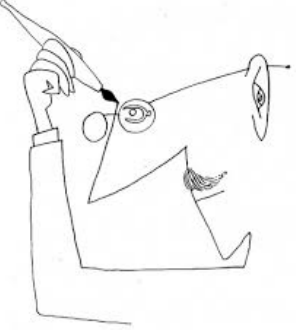
Figure 2. S. Steinberg, Selfportrait , 1945.